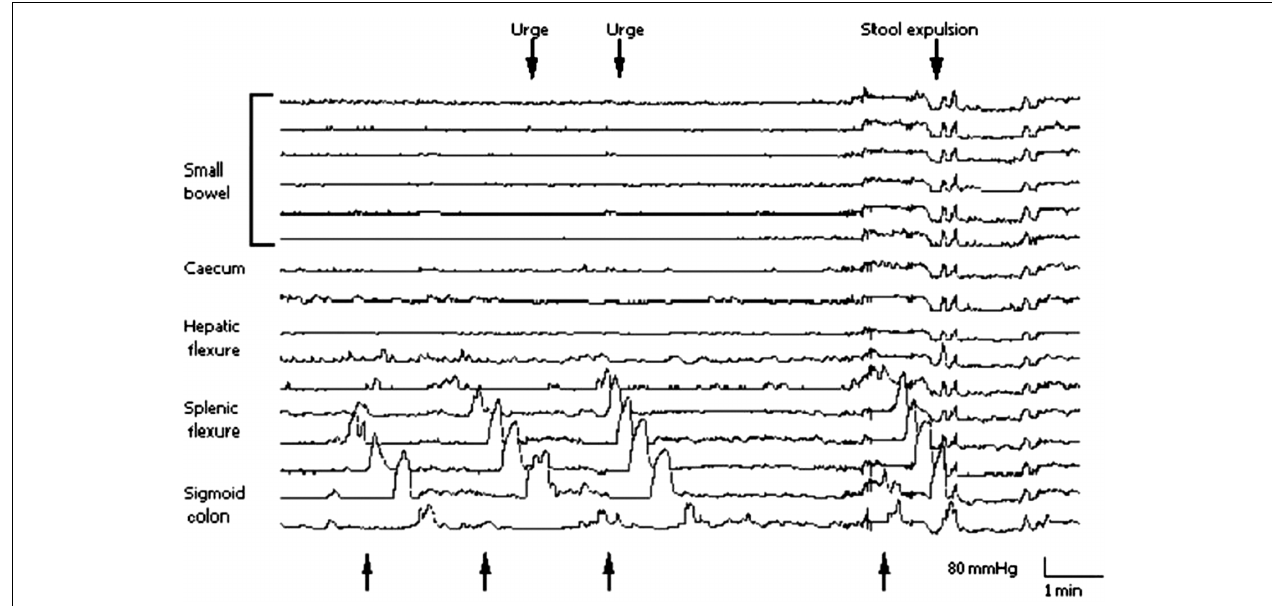
second and third GMCs caused urges to defecate.The fourth GMC propagated to the end of the colon and caused defecation. (Reproduced with permission from Bampton et al.,